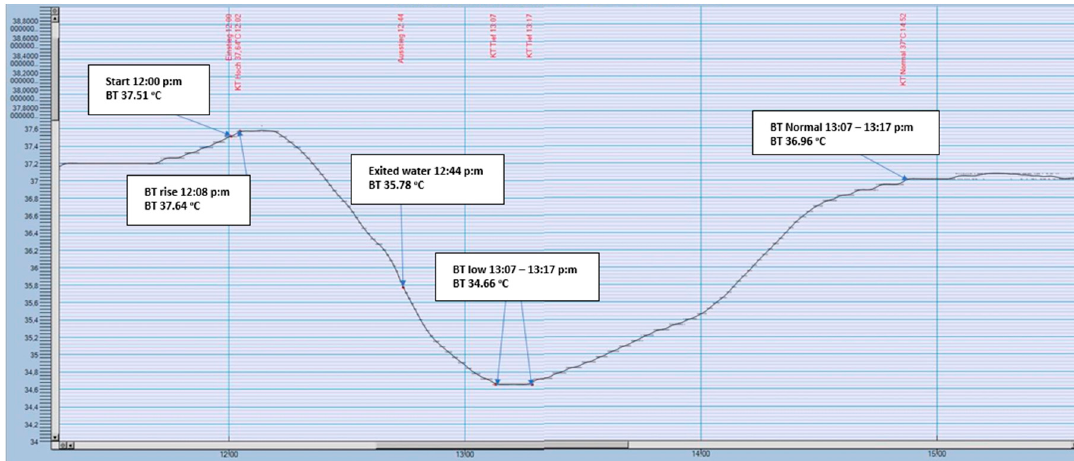
Figure 3. Body core temperature before, during and after an ‘Ice Mile’ (data provided by the athlete with his permission).